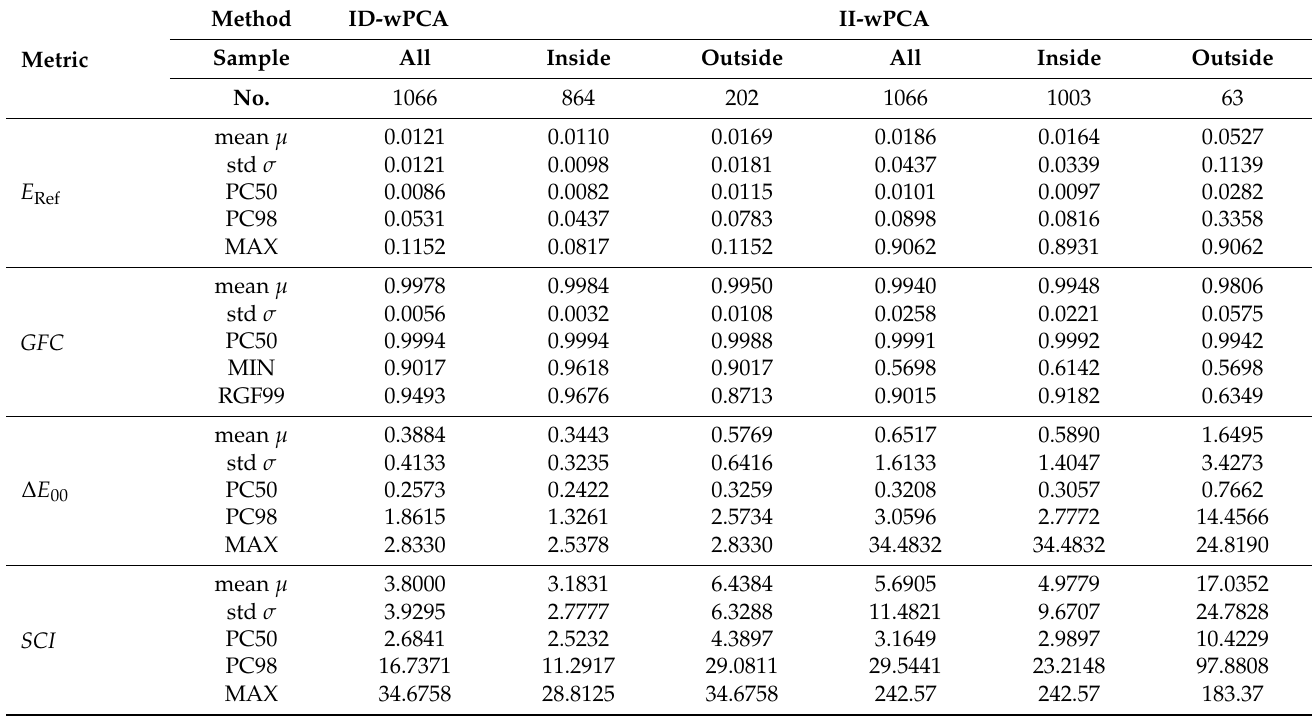
Table 6. Assessment metric statistics for the test samples using the ID-wPCA and II-wPCA methods, where the camera is the D5100